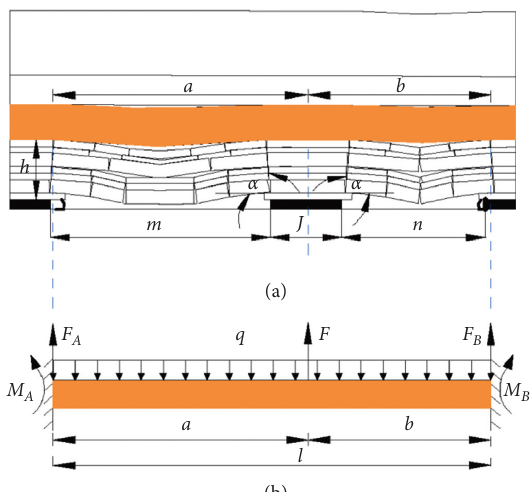
Figure 5: Mechanical model and boundary condition of the structural unit: (a) spatial structure of overlying strata and (b) simplified mechanical